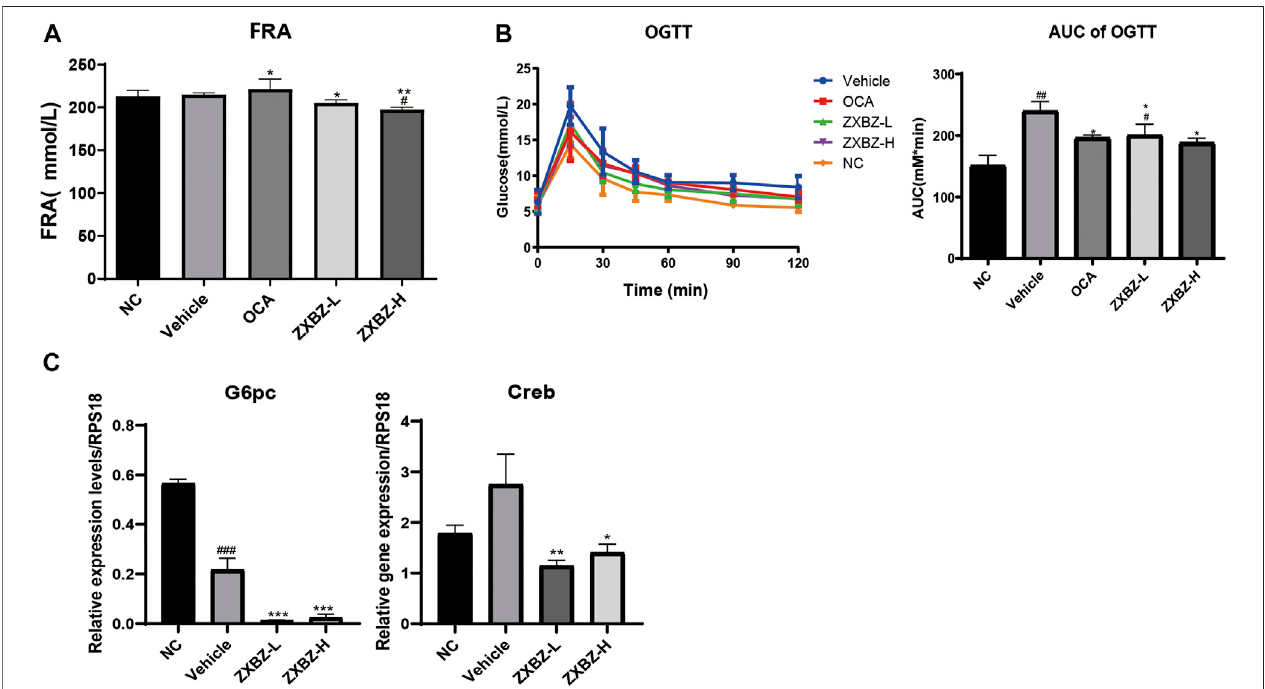
FIGURE7| ZXBZdecoctionimprovedglucosemetabolismslightly. (A) Serumfructosamineattheendpoint. (B) Oralglucosetolerancetestassayandrelatedarea under thecurve.Data areshown inmean ± SEM( n =8 – 10per group). (C) mRNA levels of related genesdetected byqRT-PCR# p < 0.05, ## p < 0.01 compared toNC. * p < 0.05, ** p < 0.01 compared to